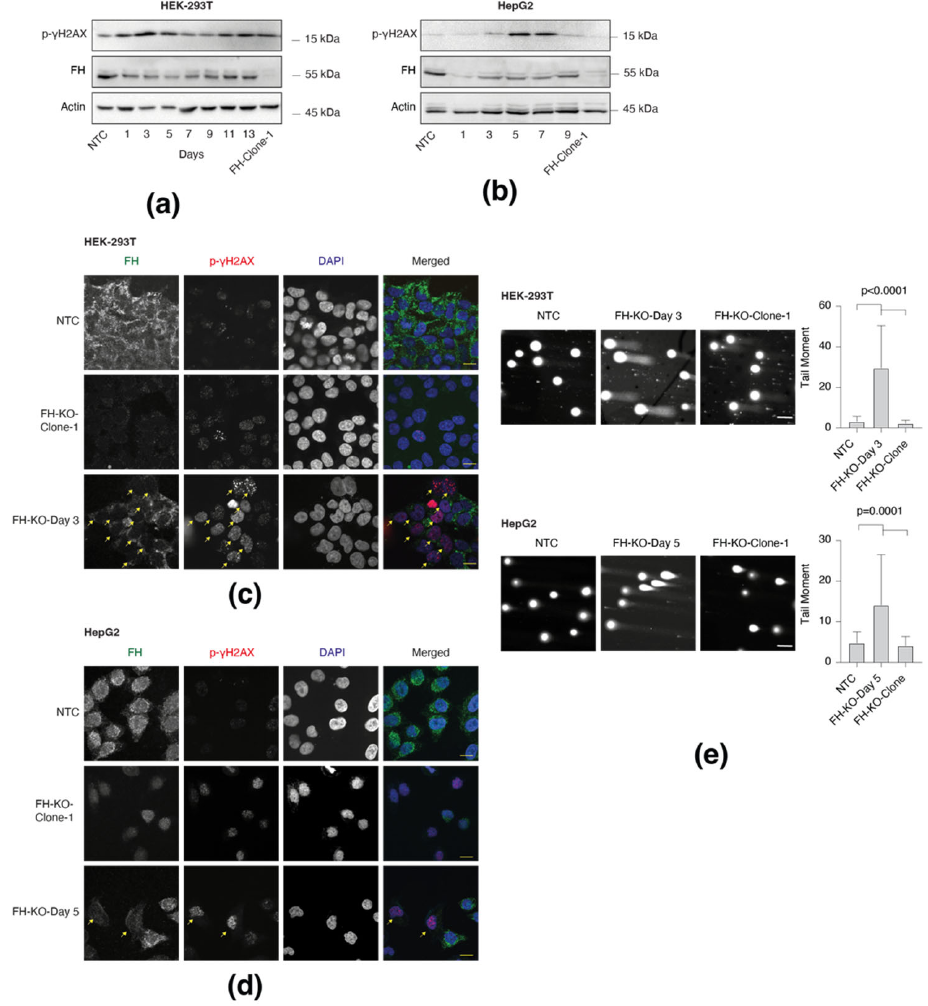
Figure 2. Short-term FH loss induces DNA damage. ( a ) γ H2AX phosphorylation is elevated in short- term FH loss in HEK-293T cells. FH expression was silenced in HEK-293T using the CRISPR-Cas9 system. On each indicated day (post-infection), the cells were lysed and subject to Western blot using the indicated Abs. FH-KO-1 are stable long-term FH knockout clones. ( b ) γ H2AX phosphorylation is elevated in short-term FH-depleted HepG2 cell line as analyzed in A. ( c ) HEK-293T cells were fixed and stained for FH (green), p- γ H2AX (red), and DAPI (blue). Bar = 10 µ m. Arrows indicate FH knockout cells. ( d ) HepG2 cells analyzed as in C. Bar = 10 µ m. ( e ) Short-term FH loss induces DNA breaks. NTC, short-term, and long-term FH-KO cells in both HEK-293T and HepG2 were subjected to the comet assay. Representative images of each sample (left). Bar = 10 µ m. Quantification of data is reported as the number of tail moments (right); each bar represents the mean ± SD for n ≥ 30. The p -value was determined by Student’s t -test. The uncropped Western Blot images can be found in Figure